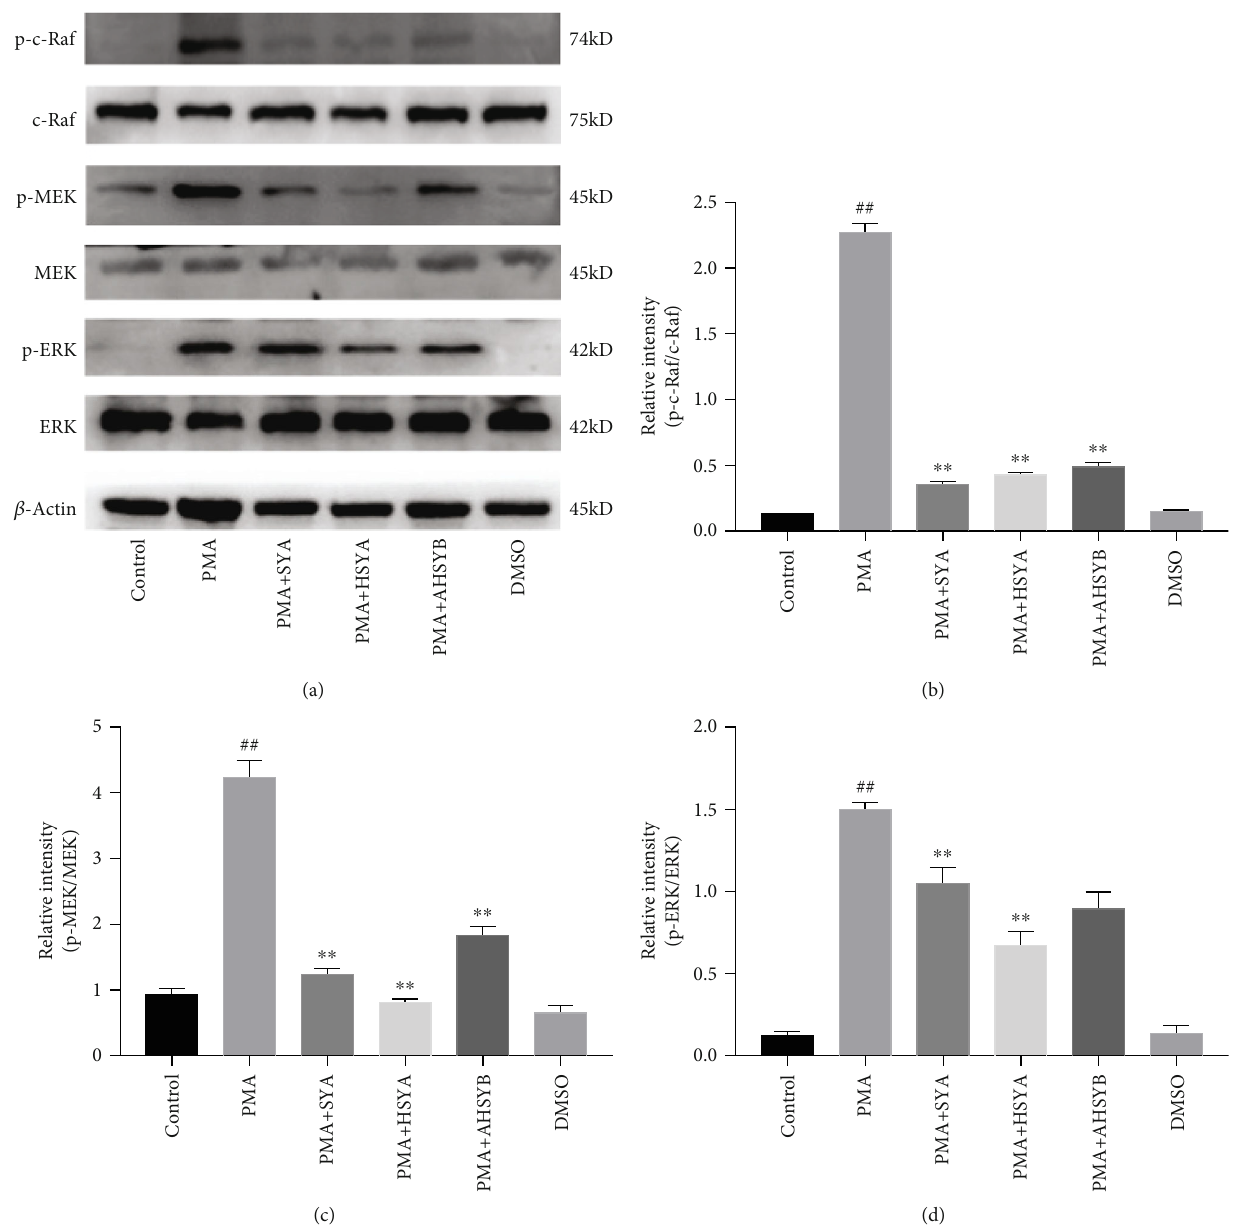
Figure 8: E ff ects of SYA, HSYA, and AHSYB on Raf/MEK/ERK signaling pathway expression in cells. (a) Protein levels of p-c-Raf, c-Raf, p-MEK, MEK, p-ERK, and ERK in cell homogenates were assessed by western blot analysis 3 h after PMA stimulation. (b – d) Densitometric analysis of the relevant bands was performed. The values presented are mean ± SEM . ## P < 0 : 01 vs the control group; # P < 0 : 05 vs the control group; ∗ P < 0 : 05 vs the LPS group; ∗∗ P < 0 : 01 vs the LPS